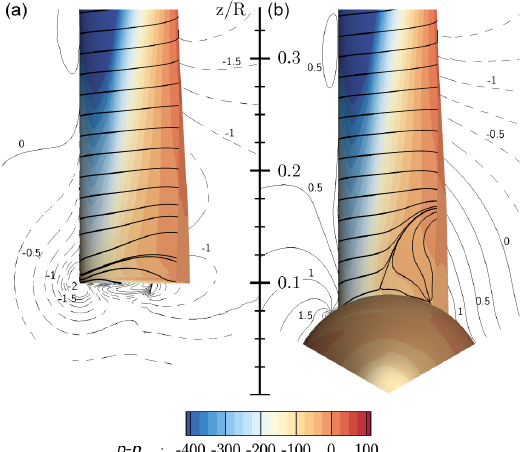
Figure 9. Visualization of three-dimensional flow in the root re- gion using streamlines and pressure contours on the suction side of the blade for CaseIsoRotor (a) and CaseT1.0 (b) . The contour lines indicate the “deviation velocity” e w from the ideal kinematic value − (cid:127)y in a slice at x = 2m.